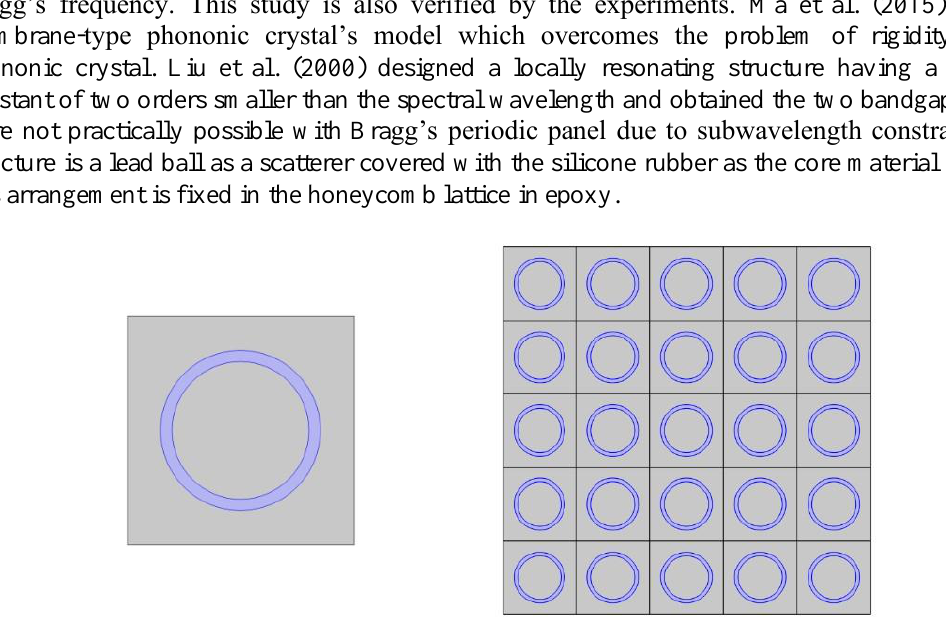
Figure 3. Locally resonating Phononic crystal with unit cell.